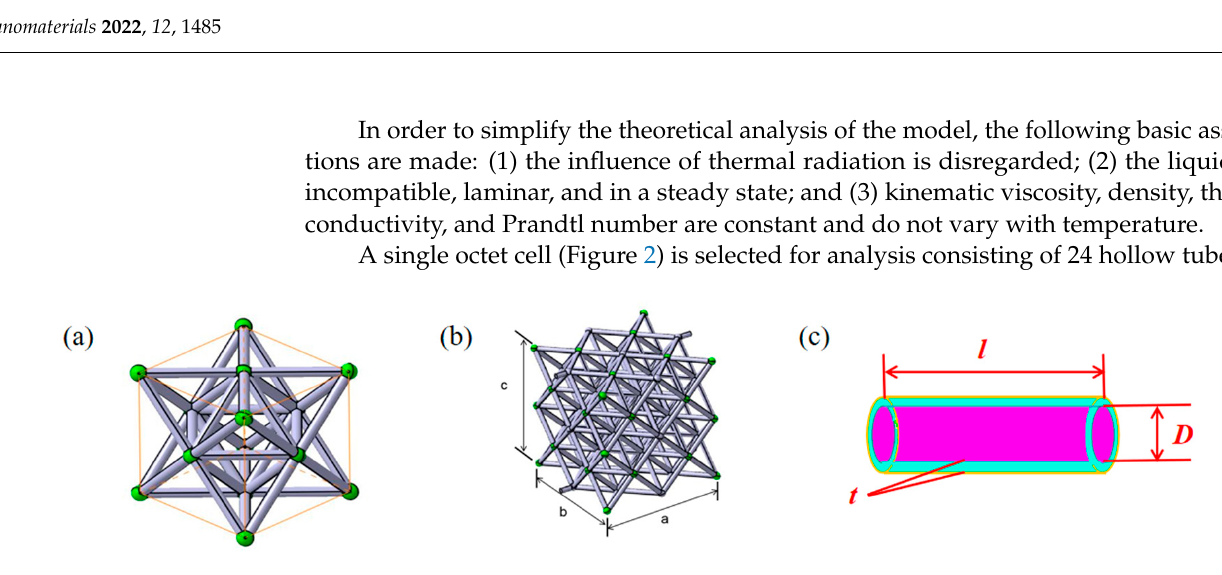
Figure 2. The ( a ) unit-cell, ( b ) structure of the microlattice material, and ( c ) hollow tube. From Figure 2, it can be seen that the unit cell is composed of 24 thin tubes with a diameter of D , a thickness of t , and a length of l . Thus, the mass of one unit-cell of